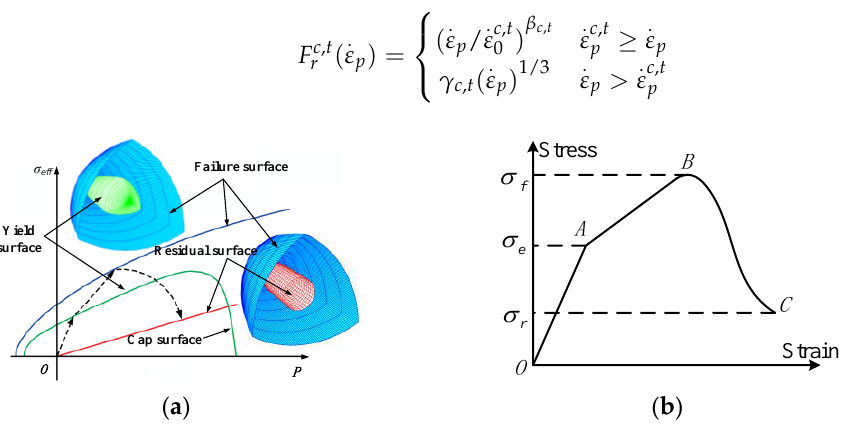
Figure 5. RHT model [28]: ( a ) Three limit surfaces; ( b ) Deviatoric stress – strain relationship. Table 5. RHT model parameters of concrete [26].